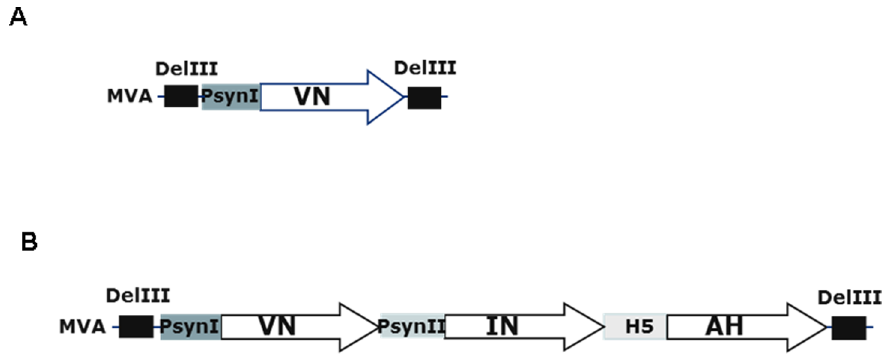
Figure 1. Schematic representation of recombinant MVAtor genomes. HA gene of A/Vietnam/1203/04 (MVAtor-mono-HA) (A) or HA genes of A/Vietnam/1203/04 (VN), A/Indonesia/CDC669/06 (IN), A/Anhui/01/05 (AH) (MVAtor-tri-HA) (B). Abbreviations: DelIII = deletion III; PsynI = synthetic promoter I; PsynII = synthetic promoter II; H5 = H5 promoter. Arrows indicate the direction of transcription. doi:10.1371/journal.pone.0107316.g001 PLOS ONE |